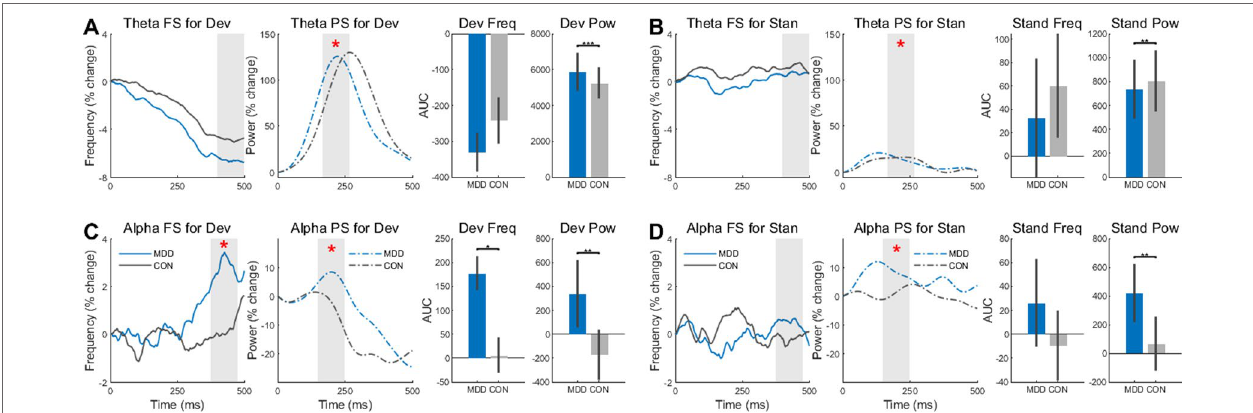
FIGURE 4 | Frequency Sliding (FS) and Power Sliding (PS) found greater changes to deviant stimuli in the MDD group for theta and alpha frequency bands. (A) In the deviant stimuli, Theta PS was higher in the MDD group and lower (B) for standard stimuli. (C) In the alpha band, both FS and PS were significantly higher for the deviant stimuli in the MDD group. (D) Only the PS was higher in the MDD group for standard stimuli in the alpha band. Area under the curve for 100ms time intervals were measured. Time intervals are shown with grey shading. All p -values are FDR corrected for multiple comparisons. *: < 0.05, **: < 0.01, ***: